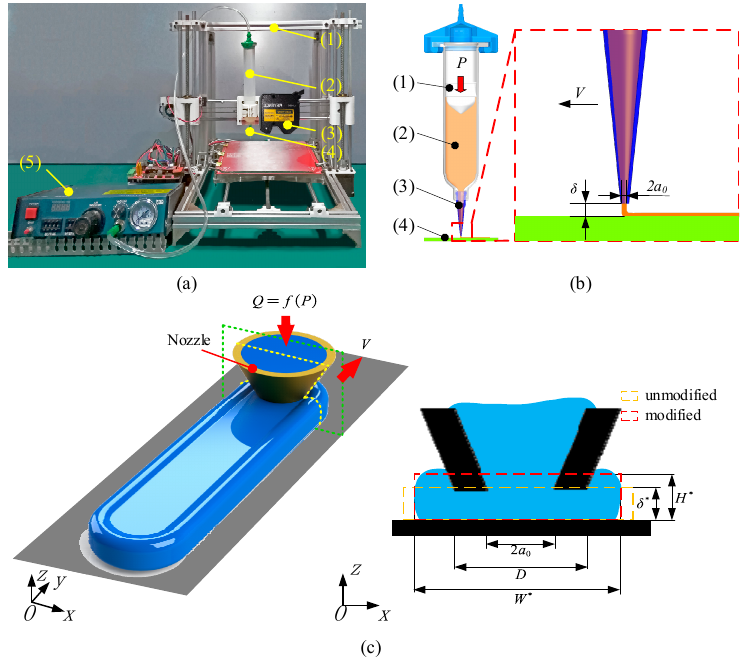
Figure 1. ( a ) AM machine: (1) motion control platform; (2) silicone container; (3) laser displacement sensor; (4) nozzle, which is used to replace (2) when scanning profiles; and (5) 982A fluid dispenser. ( b ) The schematic diagram of printing parameters: (1) piston; (2) silicone; (3) nozzle; (4) substrate, nozzle moving speed V , the inner diameter of nozzle tip 2a 0 and gap between the nozzle tip and substrate δ . ( c ) Schematic diagram of strand width model correction.